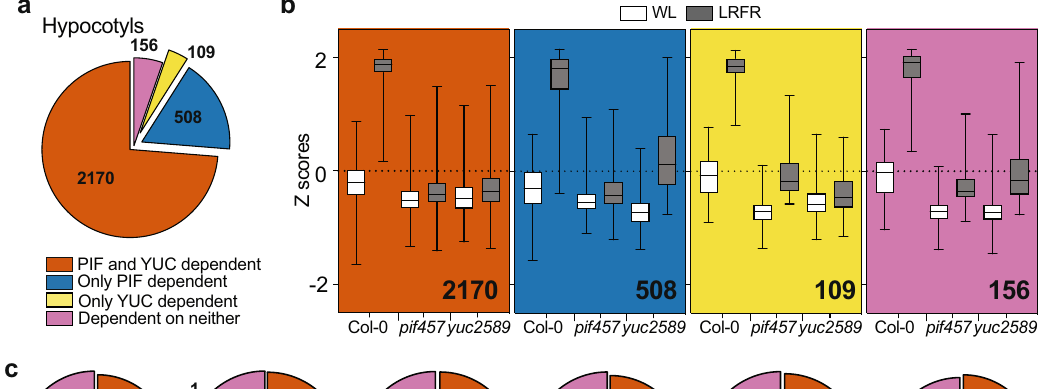
percentile, whiskers extend to show the data range. c The distribution of hypocotyl-induced genes according to the dependence on PIFs and YUCs in each of the selected signi fi cantly enriched GO terms. Numbers indicate sig- ni fi cantly regulated genes in the given categories and/or GO terms. The full list of misregulated genes and enriched GO terms are given in Supplementary Data 3. See also Supplementary Fig.